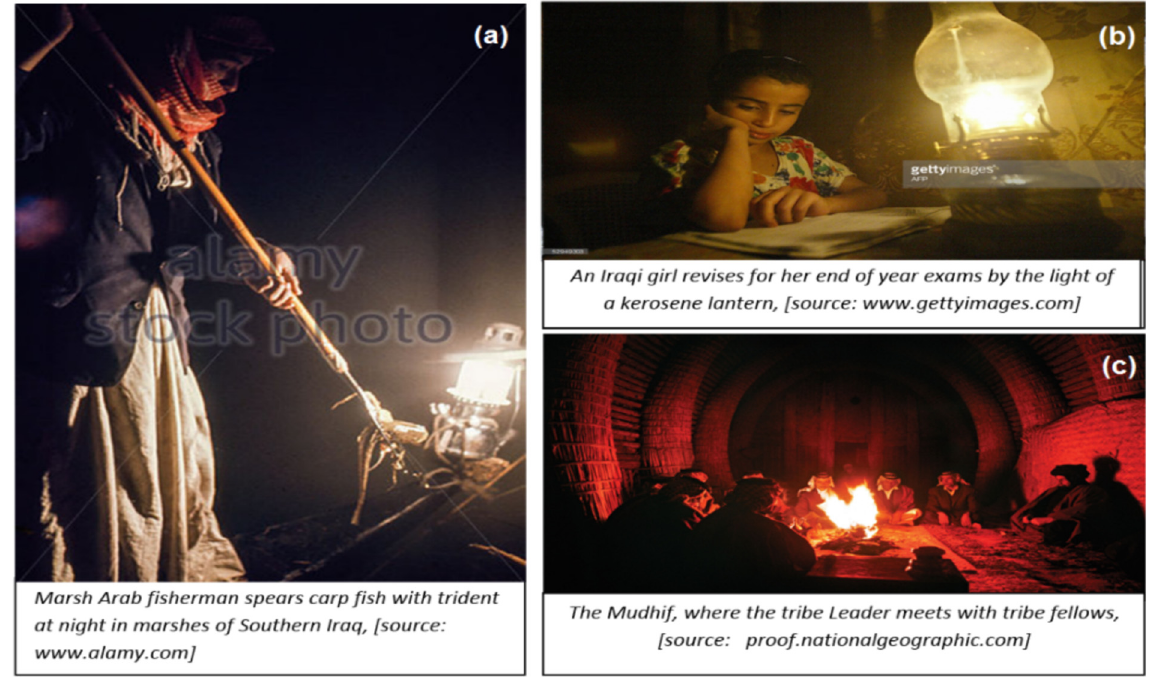
Fig. 2. Chibayish villagers lighting and night fi shing: (a) kerosene mantel lantern; (b) kerosene lantern; and (c) open fi